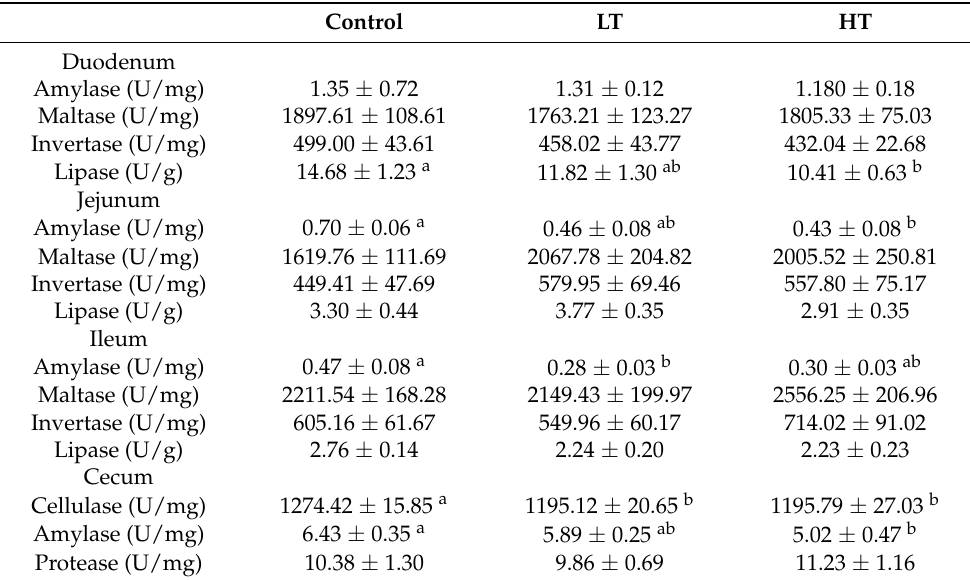
Table 3. Effect of TA on the intestinal enzyme activities of Brandt’s voles.